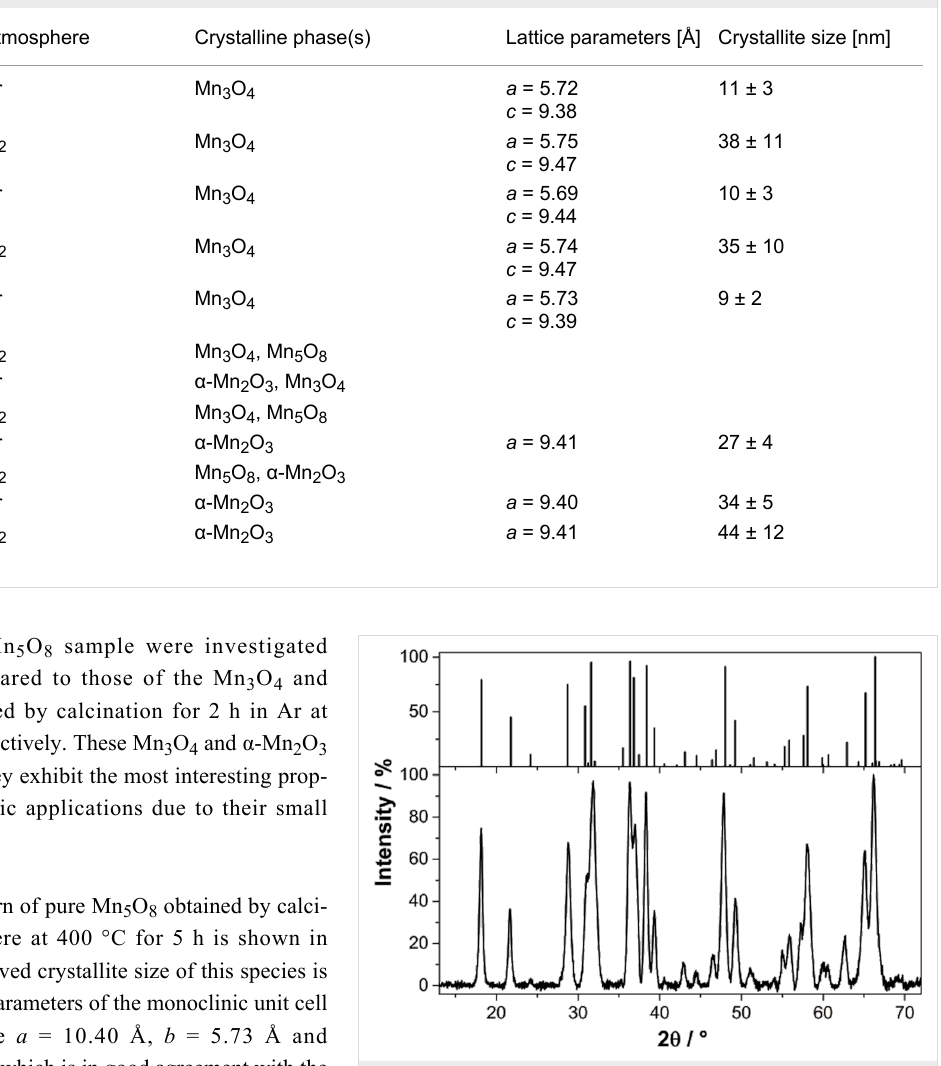
Table 1: Crystalline manganese oxide phases obtained after calcination for 2 h in an Ar flow and an O 2 flow (50 NL/h) at different temperatures; mean Scherrer crystallite sizes (from all assigned reflections) and lattice parameters (from the (101) and (004) reflections of Mn 3 O 4 as well as the (400) reflection of α -Mn 2 O 3 ) were calculated for samples yielding pure phases.